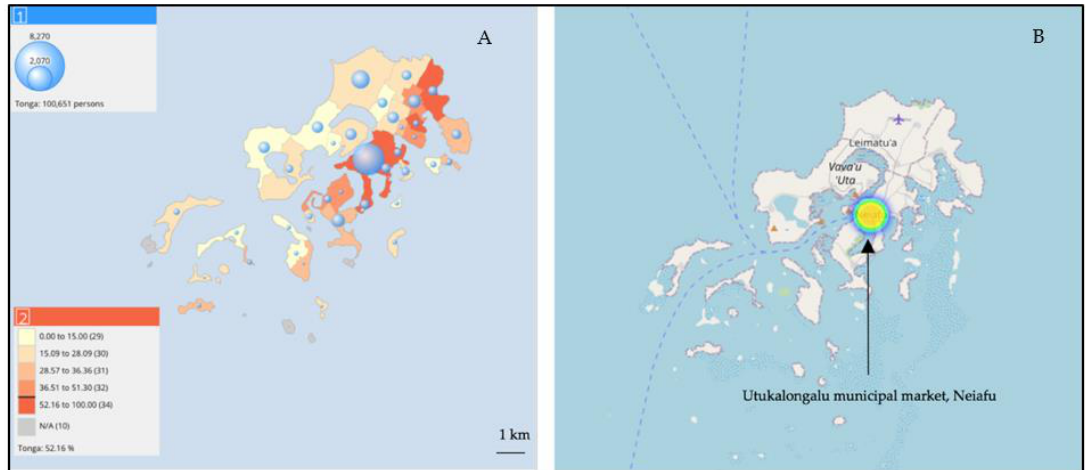
Figure 3. ( A ) Number of households on ‘ Utu Vava ’ u Island not producing crops for sale or home use, with population density overlay. ( B ) Heat map of ‘ Utu Vava ’ u Island, illustrating the concentration of market vendors at the Utukalongalu municipal market. Map source: ( A ) PopGIS Tonga 2016 Population and housing census data. Tonga Department of Statistics. ( B ) Openstreet map and KoBoToolBox™ with survey data overlays.